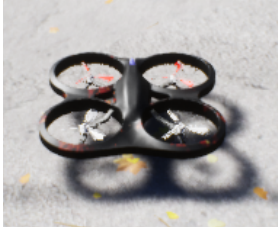
Figure 3. Quadcopter used in